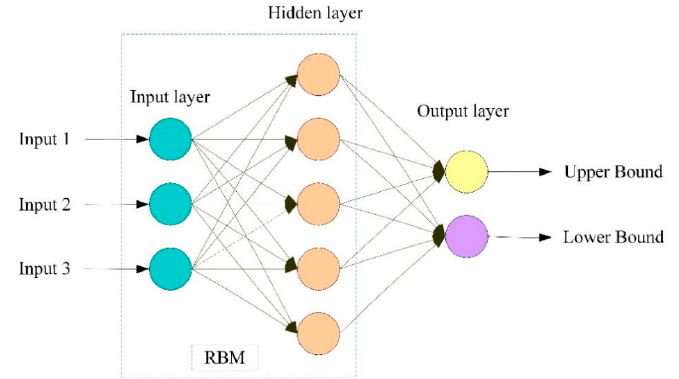
Figure 4. Illustration of the lower and upper bound estimations by DBN.